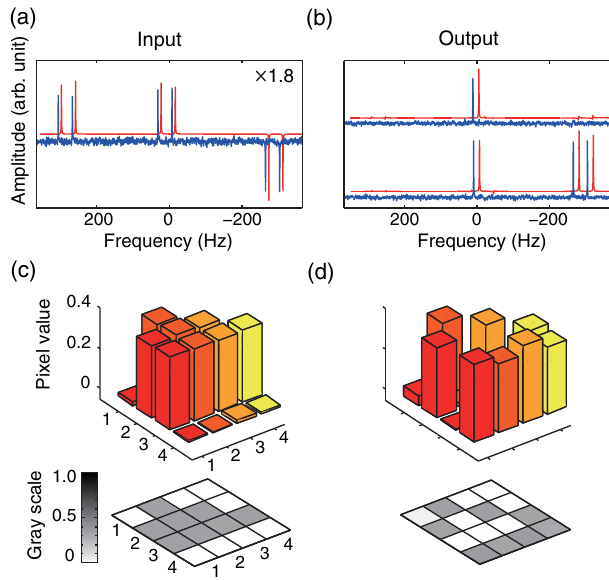
FIG. 7. Experimental results of the QHED algorithm. The upper panels are the 13 C spectra (blue curves) for (a) the input image F and (b) output image representing the edge information, e along with the simulated ones (red curves). The simulated spectra are shifted for clarity. In (a), the spectral amplitude is zoomed-in by 1.8 times. In (b), the top (bottom) spectrum is the result after i (the processed image j f 0 i after applying a Hadamard gate to j f e e the amplitude permutation). The 13 C spectra were obtained by applying π = 2 readout pulses. The lower two panels are the image array results of (c) the input 4 × 4 image and (d) the output image representing the edge information. The images are plotted as amplitude 3D bar charts (top) and 2D visual intensity pictures (bottom) with each square representing one